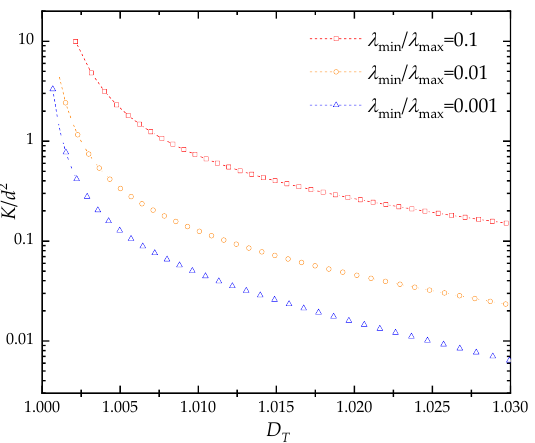
Figure 9. The effect of tortuosity fractal dimension on the dimensionless through-plane permeability of fibrous porous material.